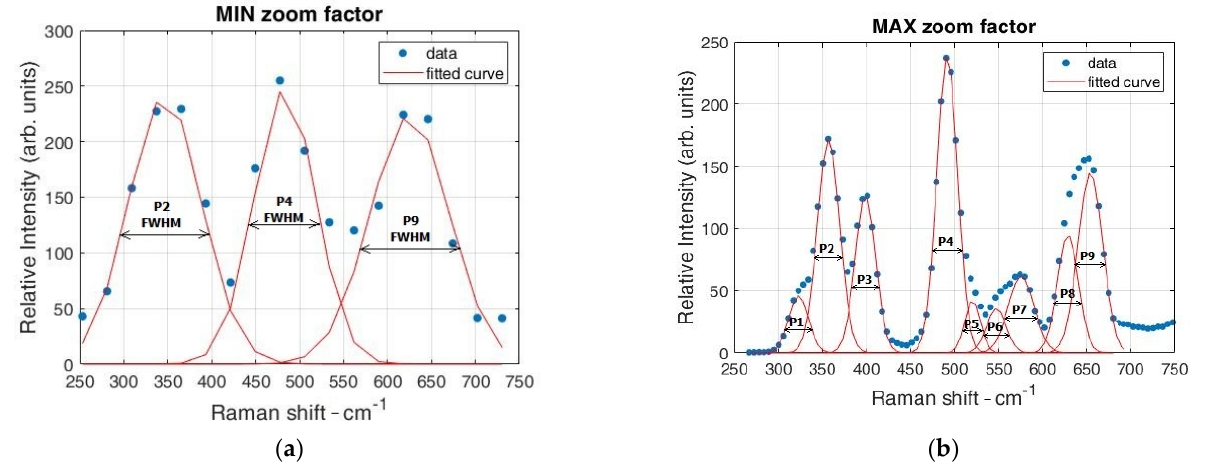
Figure 5. Calculation of the spectral resolution of the proposed system with a ZrO 2 Raman spectrum using the Gaussian fit for each Stokes peak at different ZF. Note the difference in the number of peaks and fitted curves at the same spectral interval for minimum ZF ( a ) and maximum ZF ( b ).